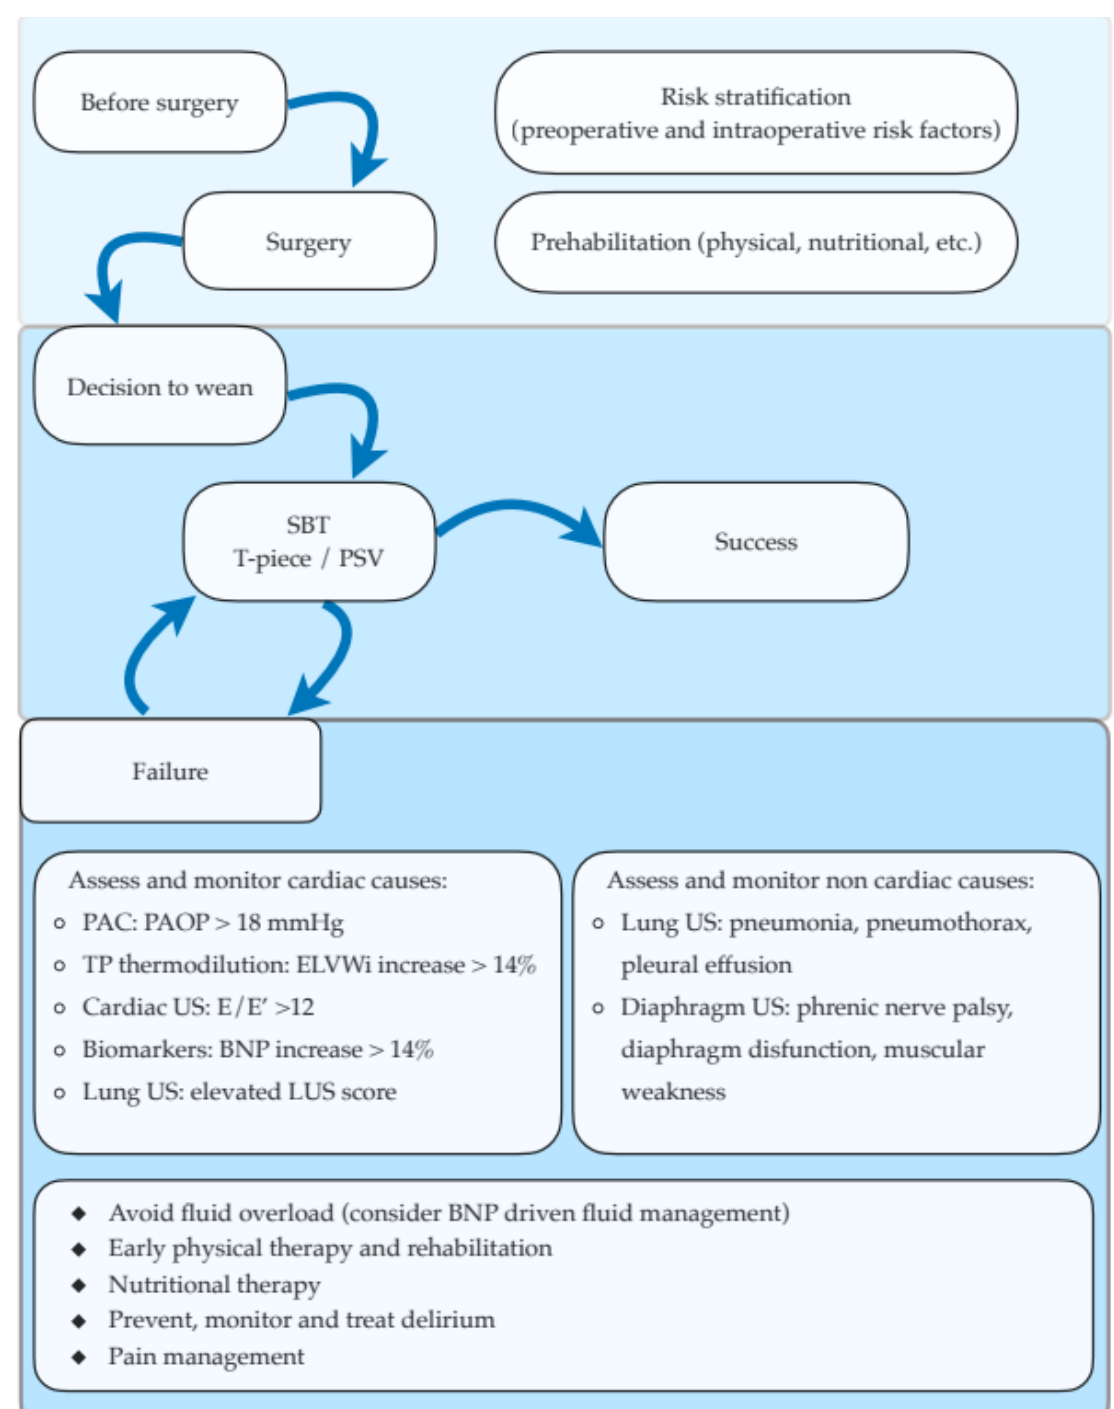
Figure 2. Management algorithm of respiratory weaning after cardiac surgery. After the decision to wean is taken, a SBT is performed by either a T-piece trial or a PSV trial with low or no PEEP. If a SBT fails, possible cardiac and non-cardiac causes of failure need to be assessed and actively monitored during subsequent SBTs. Interventions to facilitate weaning include adequate fluid management, early initiation of physical therapy and nutritional support, and prevention and management of both delirium and postoperative pain. BNP, brain-derived natriuretic peptide; PAC, pulmonary artery catheter; PAOP, pulmonary artery occlusion pressure; PEEP, positive end expiratory pressure; PSV, pressure support ventilation; SBT, spontaneous breathing trial; TP trans-pulmonary; US, ultrasoun d.